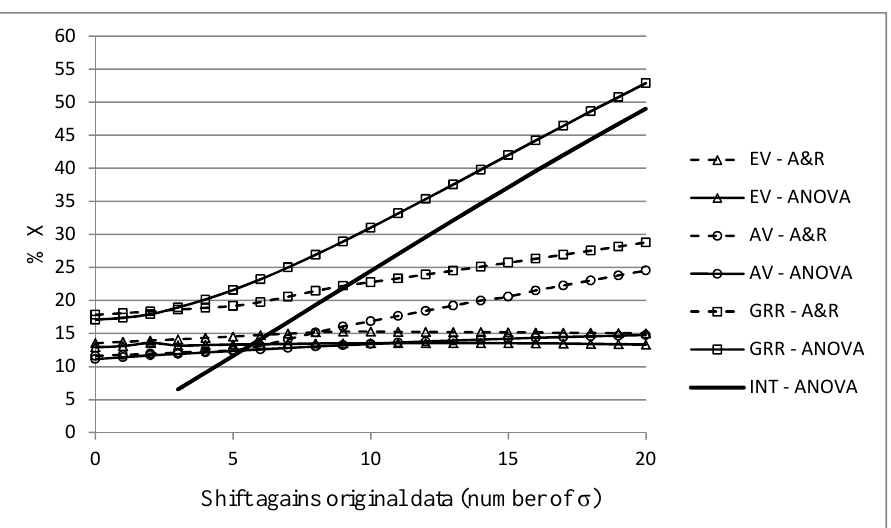
Figure 5 Changes in GRR study results for Simulation